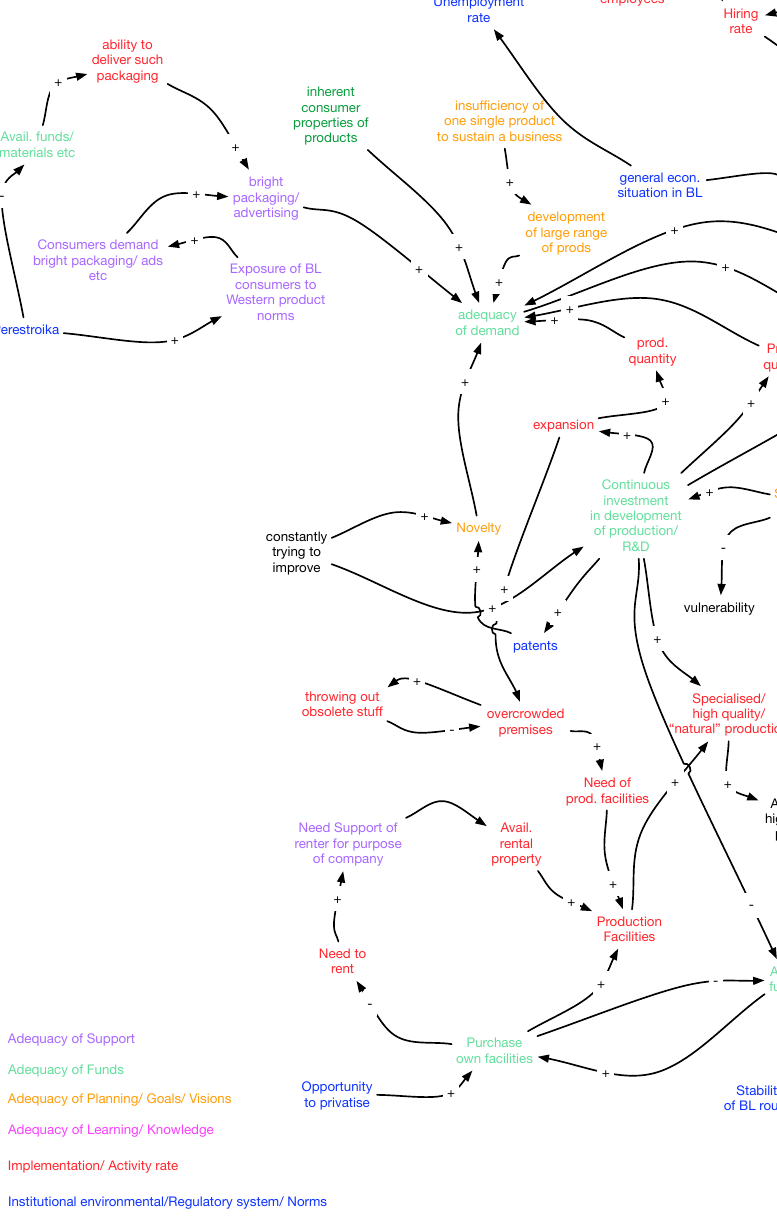
Figure A2:14. Case Berries, Theme: Financing,